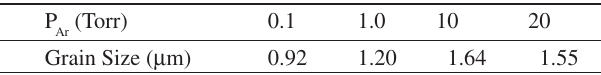
Table 5. Grain size of CdTe films deposited at T under different argon pressures.